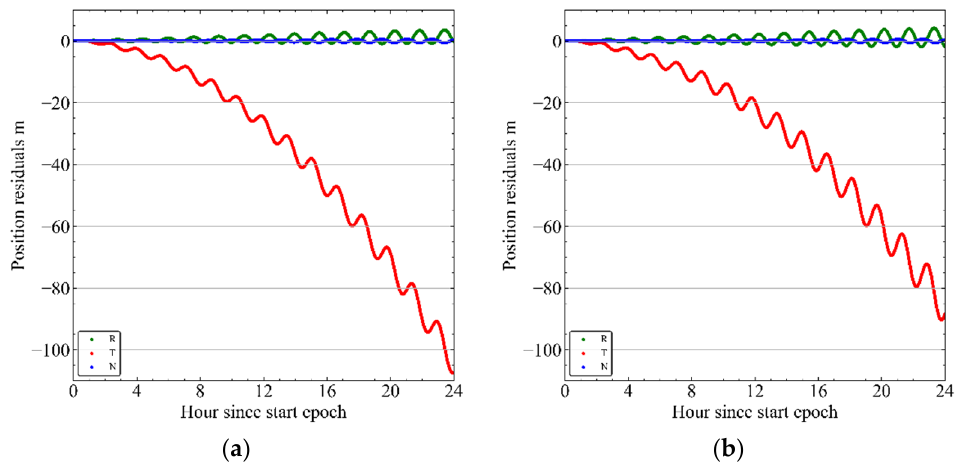
Figure 11. At low magnetic activities, orbit propagation error magnitudes, without ( a ) and with ( b ) calibration of the derived densities. R is the radial direction, T is the along-track direction, and N is the cross-track direction.